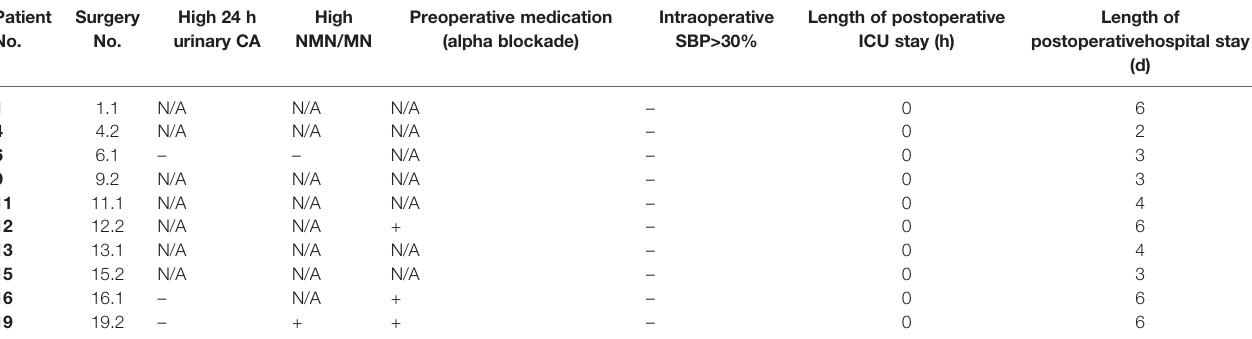
TABLE 4 | Clinical features and outcomes of non-pheochromocytoma resection surgeries performed without the condition of pheochromocytoma in 10 MEN2A cases. Patient Surgery No.